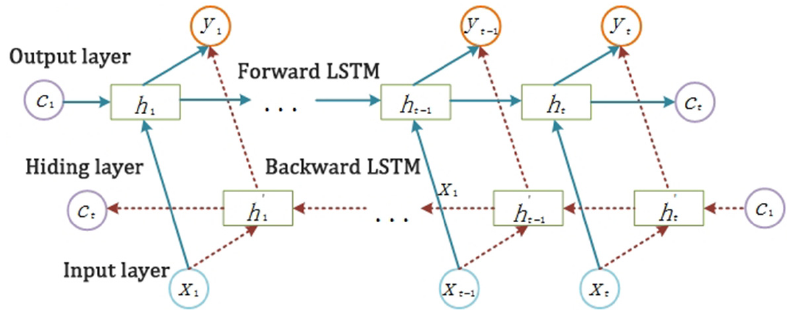
Figure 3. The structure of the Bi-LSTM model.